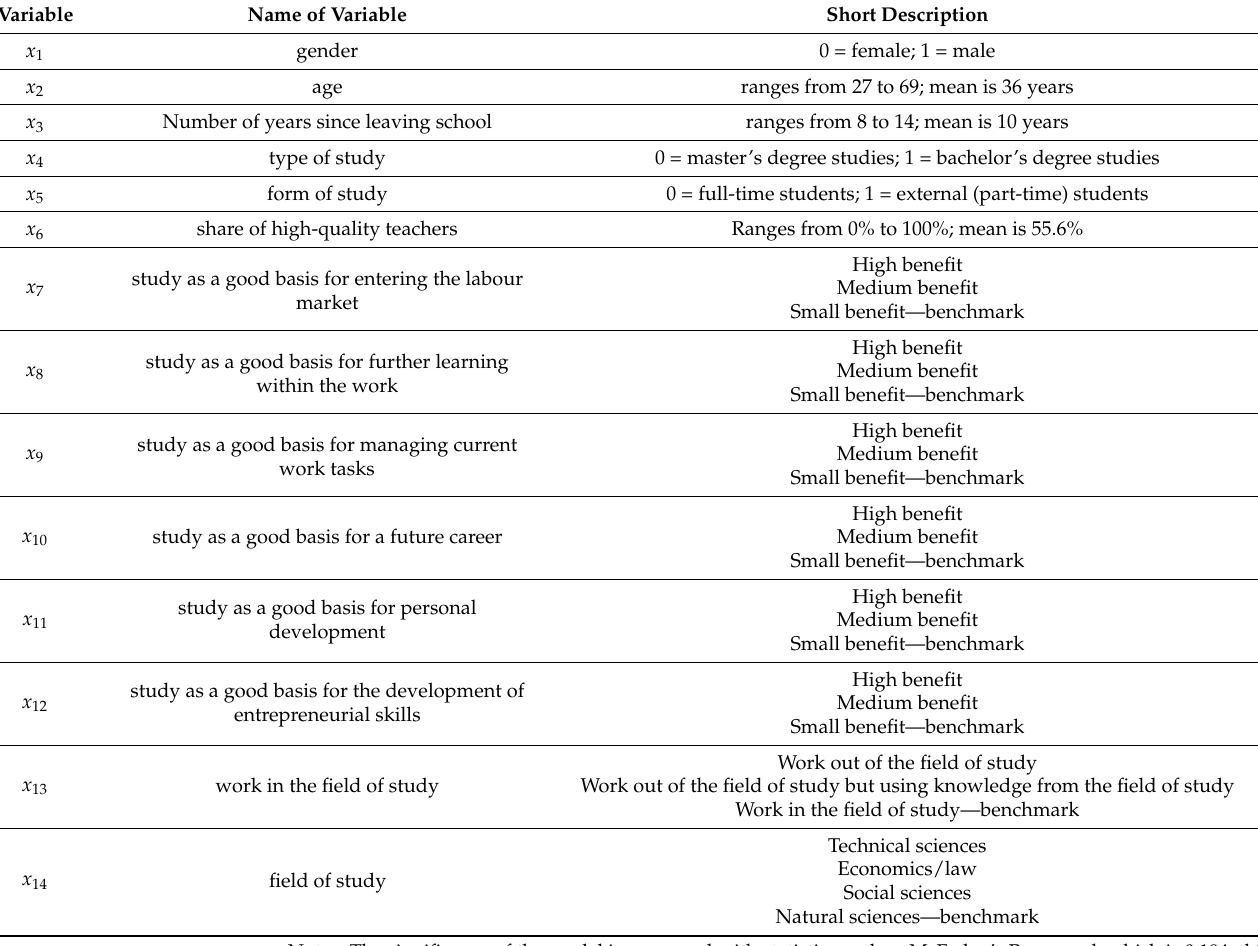
Table 1. Independent